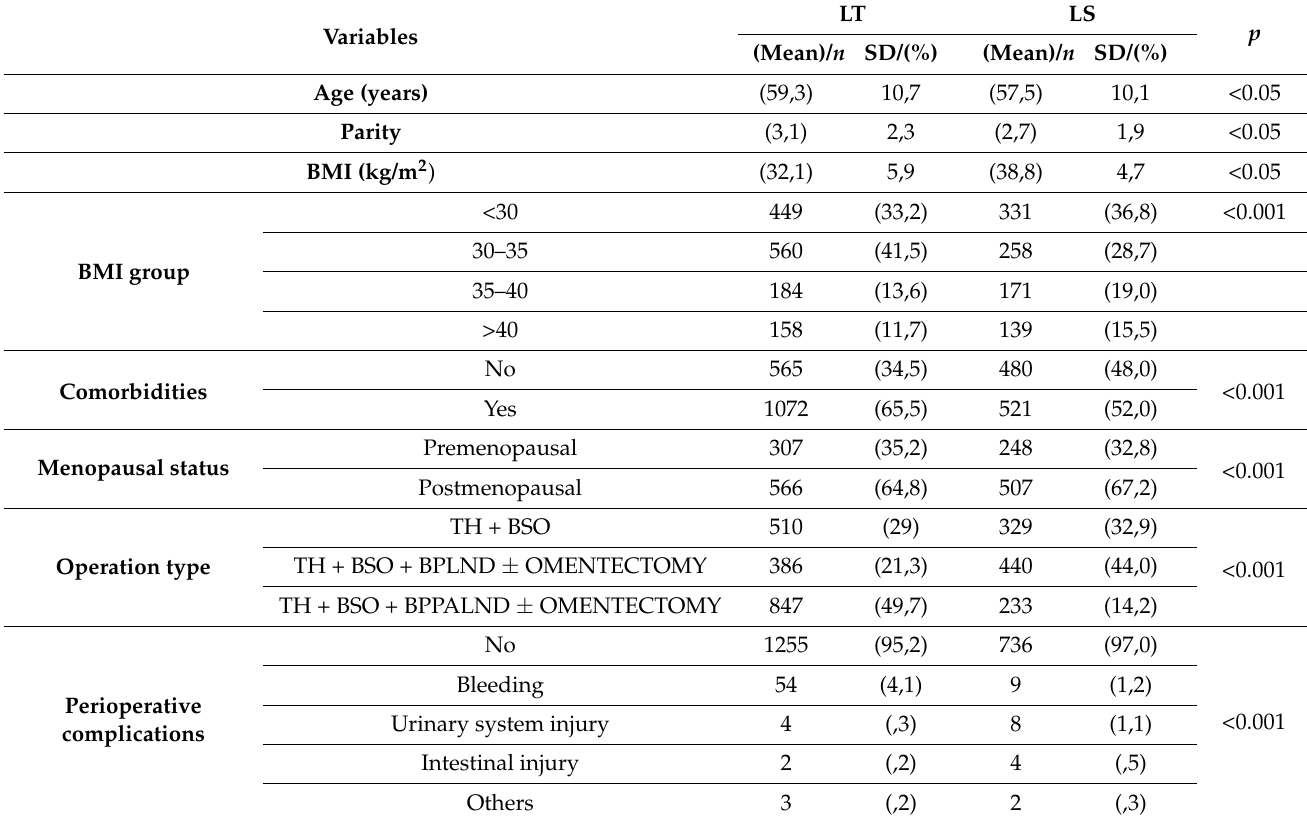
Table 1. Demographic and surgical characteristics of the